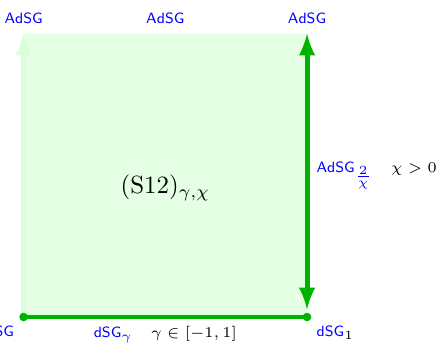
Figure 6 . Parameter space for some D = 2